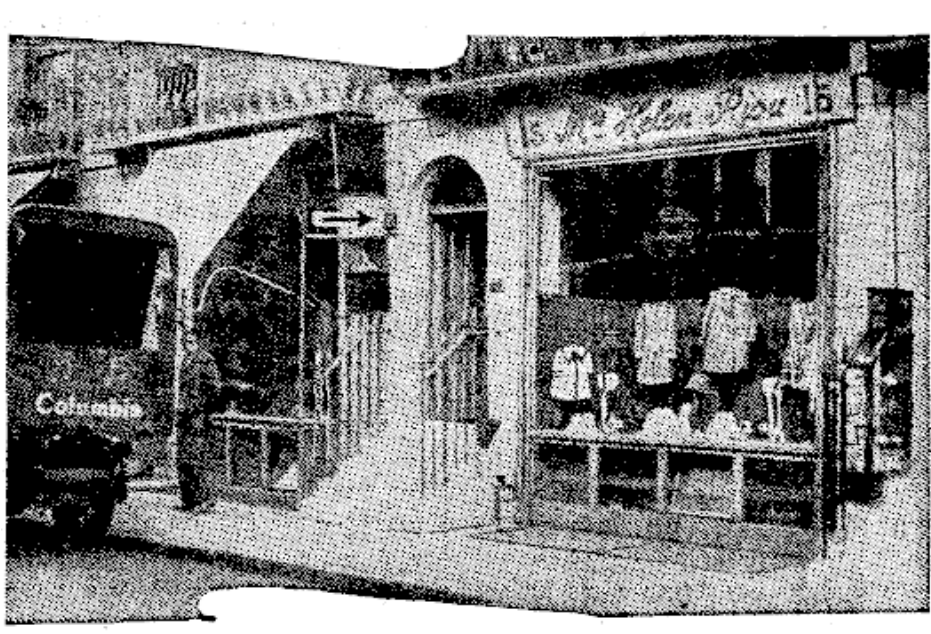
Figure 4. Beauchamp Place—microphone location in 1928.